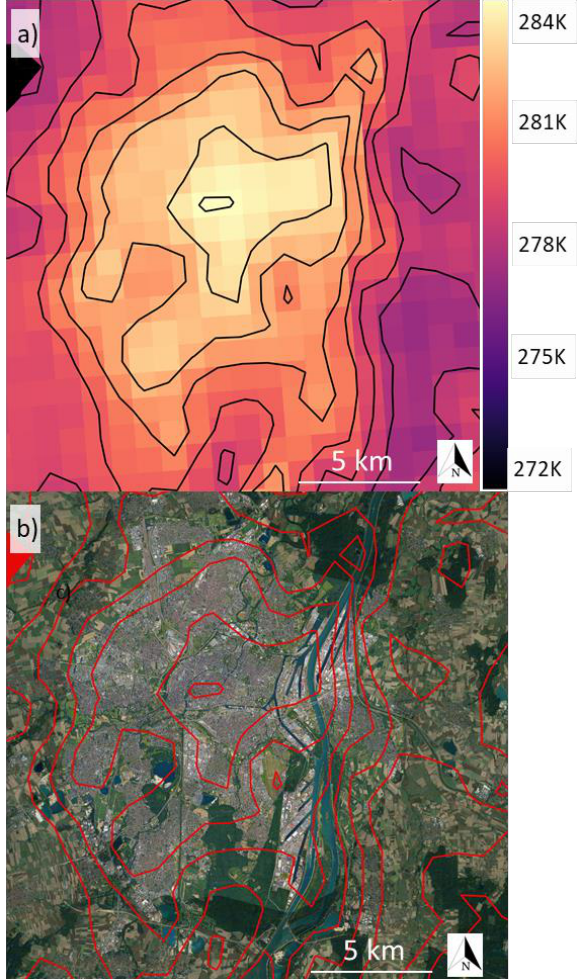
Figure 10. a) Spring UHI map of Strasbourg obtained from MOD11A1 LST product at night and b) the isotherms derived every 1K superimposed on an aerial image of the city from